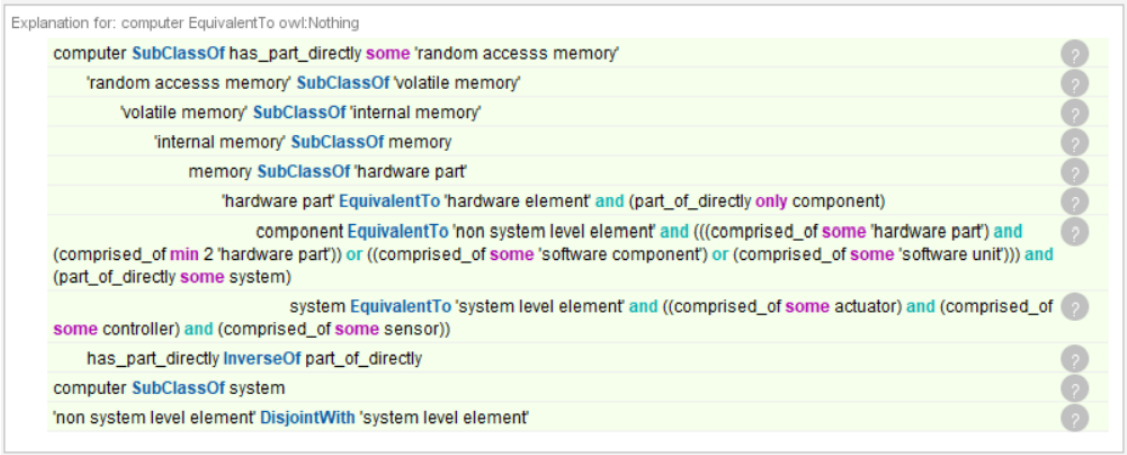
Figure 3. Reasoner output with NLP-generated sample relationship between computer and